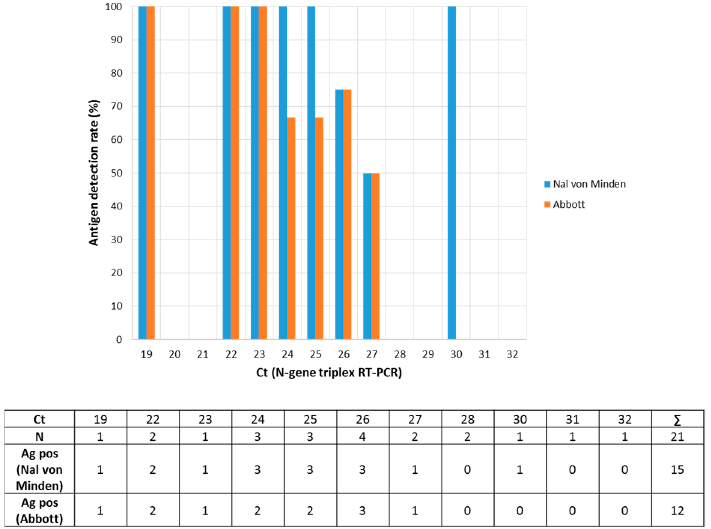
Figure 3. Head-to-head comparison of two POCTs for detection of SARS-CoV-2 antigen. Upper respiratory tract samples which have been already tested in the NADAL ® COVID-19 Ag test (Nal von Minden) were re-tested with the Panbio™ COVID-19 Antigen rapid test (Abbott, n = 21). The raw data are listed in the table below the figure.